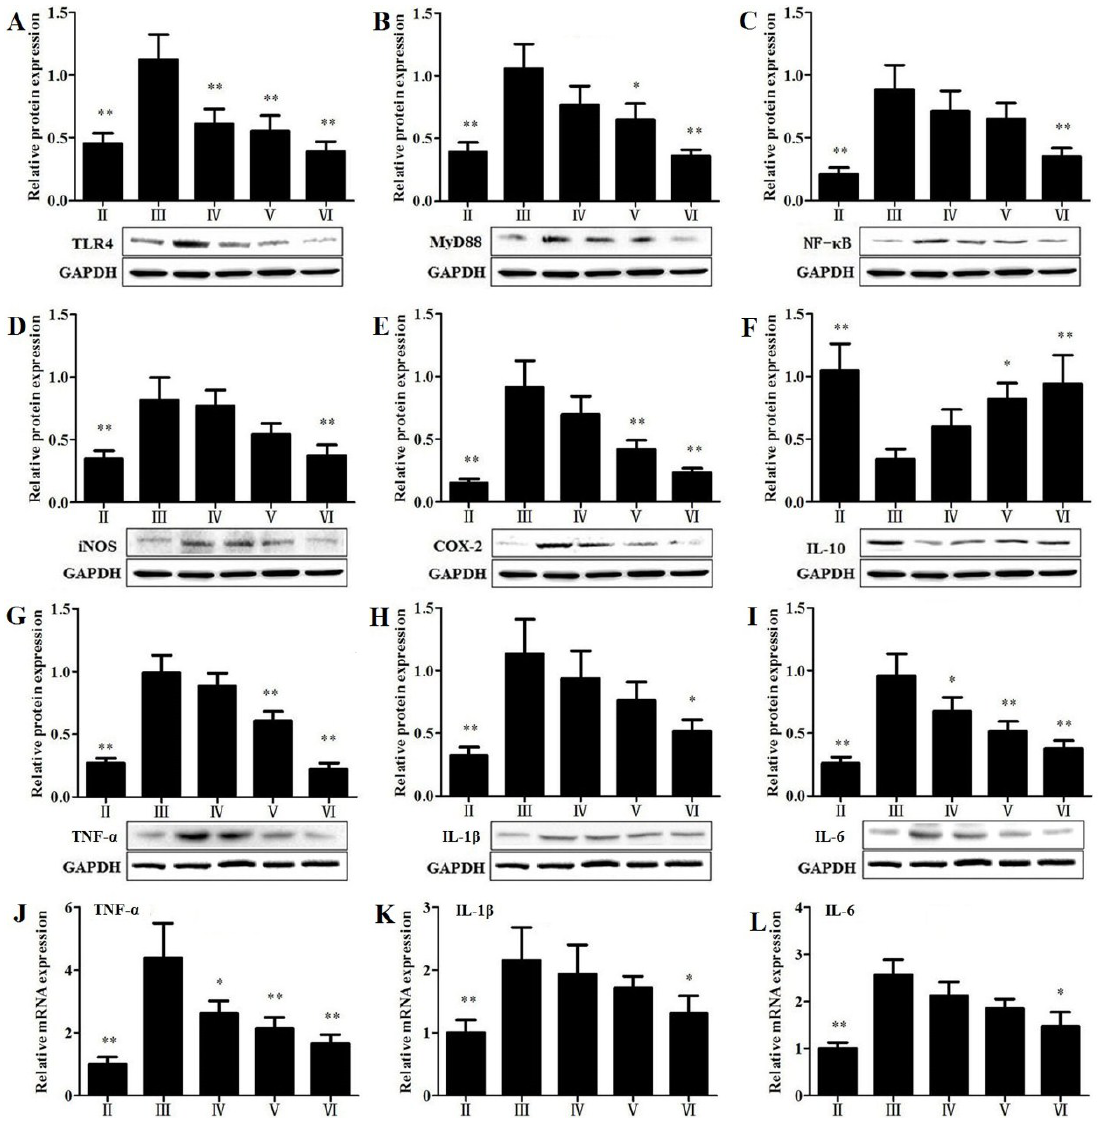
Figure 7. Effects of Rosa laevigata Michx fruit (RLTS) on the expressions of TLR4, MyD88, NF-κB, iNOS, COX-2, IL-10, TNF-α, IL-1β and IL-6 ( A–L ). ( II ) Normal control; ( III ) model; ( IV ) RLTS (70 mg/kg) + CCl 4 ; ( V ) RLTS (140 mg/kg) + CCl 4 ; ( VI ) RLTS (210 mg/kg) + CCl 4 . Values are expressed as mean ± SD ( n = 4). * p < 0.05, ** p < 0.01 vs. model